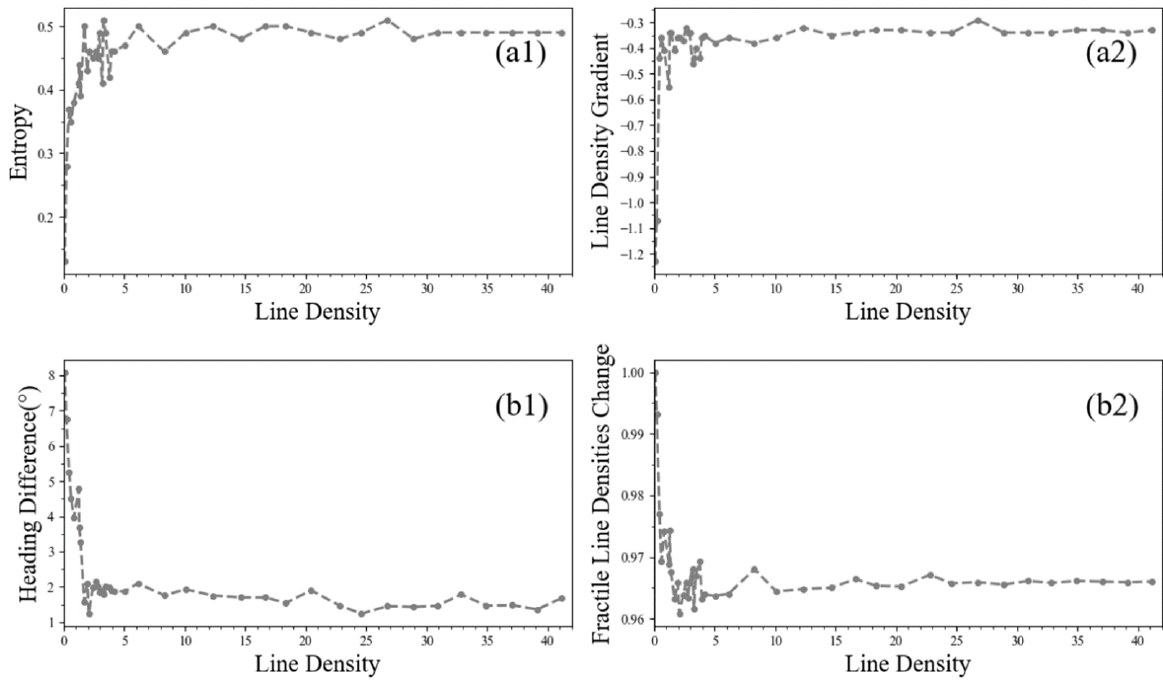
Figure 12. Effects of sample size on four parameters: ( a1 ) and ( a2 ) are about the entropy and density gradient; ( b1 ) and ( b2 ) are related to on-site heading and fractile line-density.